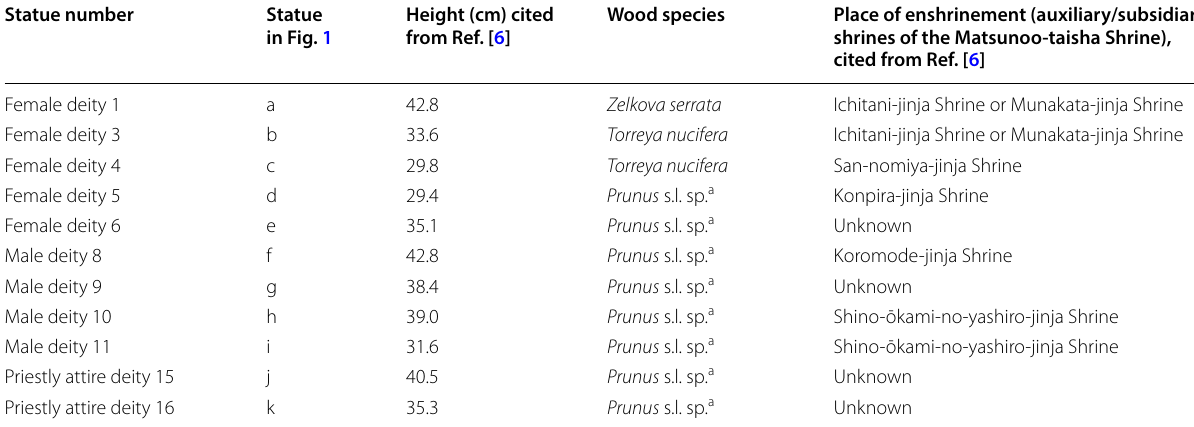
Especially, female deity statues 3 and 4 have similar ink inscriptions at the bottom though they were enshrined at different auxiliary/subsidiary shrines. From ink inscriptions, they are supposed to be made in 1143